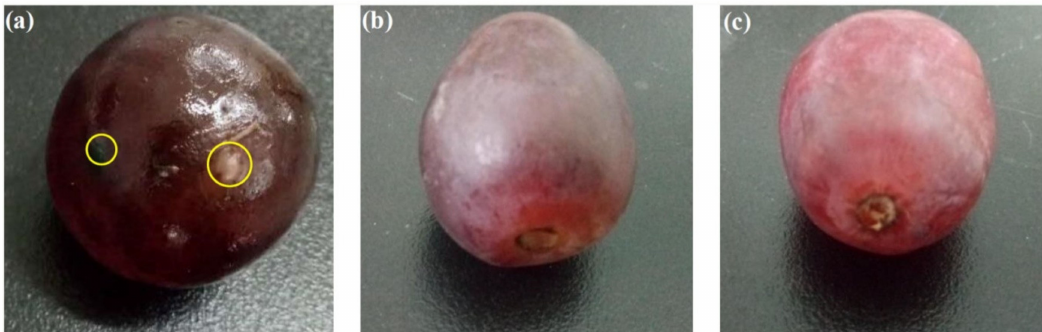
Figure 14. Preservation of red grape packed in different materials at 37 ◦ C for 6 days: ( a ) plastic wrap; ( b ) pure chitosan film; ( c ) chitosan-TiO 2 film. Reprinted from [133] with permission from